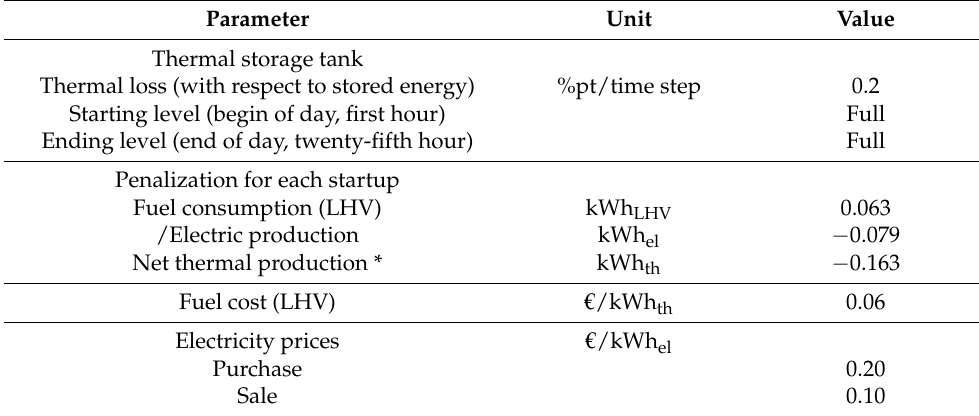
Table 3. Energy and cost assumptions adopted in the